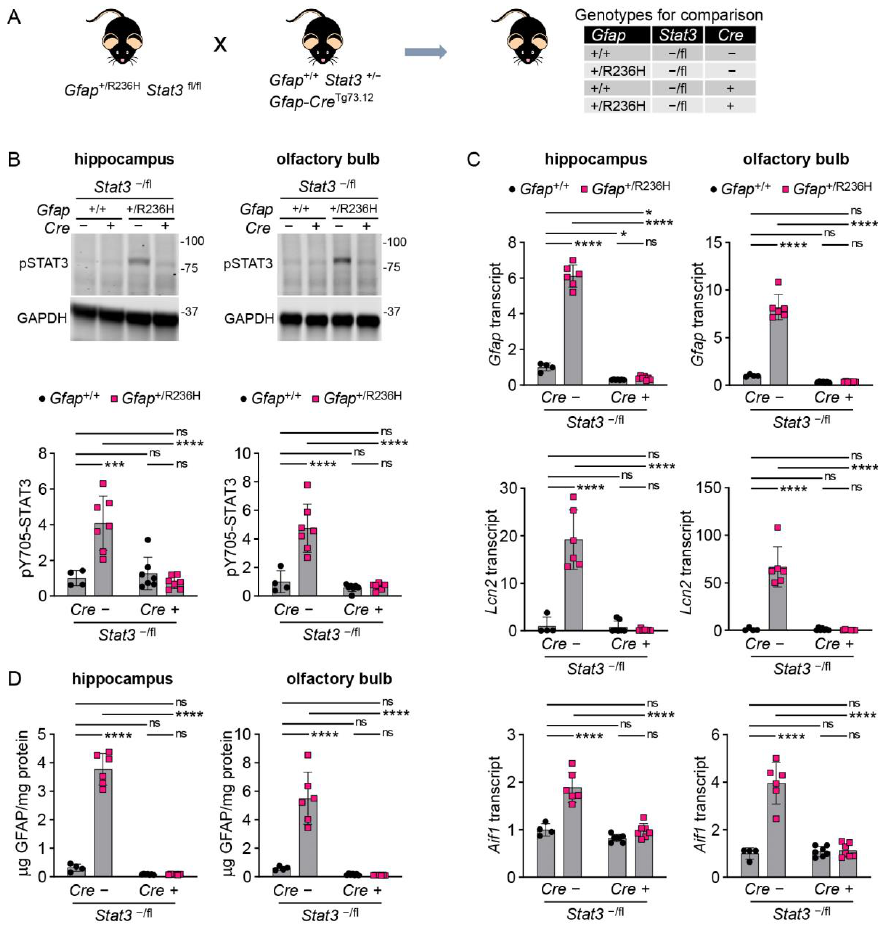
Figure 3. GFAP and stress markers in AxD model mice with conditional genetic knockout of Stat3 in Gfap expressing cells at 8 weeks of age. ( A ) Genetic cross to generate Gfap +/R236H mice and Gfap +/+ littermate controls with heterozygous knockout/floxed (-/fl) Stat3 alleles and a Gfap -promoter- driven Cre transgene Tg73.12. ( B – D ) Quantitation of pY705-STAT3 protein by immunoblotting ( B ), Gfap , Lcn2 , and Aif1 transcripts by qPCR ( C ), and GFAP protein by ELISA ( D ) in hippocampus and olfactory bulb. Values in ( B , C ) are normalized to GAPDH and Rn18s , respectively, and represent fold change relative to the average for Gfap +/+ ; Stat3 - /fl ; Cre (-) mice. C57BL/6J males and females, two- way ANOVA with Sidak’s post -tests, * p < 0.05, *** p < 0.001, **** p < 0.0001, ns = not significant. To assess whether GFAP mutation might eventually cause protein accumulation with age, we performed similar experiments in older mice (12 weeks and 6 months), when pathology was increased in the model. For these experiments, we used mice carrying the floxed Stat3 gene on both alleles (fl/fl) for a more exact comparison between full STAT3 expression and the targeted knockout condition (Figure 4A). At 12 weeks of age, we ob- served a reduction in phosphorylated STAT3 similar to that observed above at 8 weeks, and total STAT3 expression, which was also elevated in Gfap +/R236H mice, was normalized by blocking STAT3 activation (Figure 4B). GFAP protein was reduced by STAT3 inactiva- tion in all brain regions analyzed and spinal cord (Figure 4C), with no significant